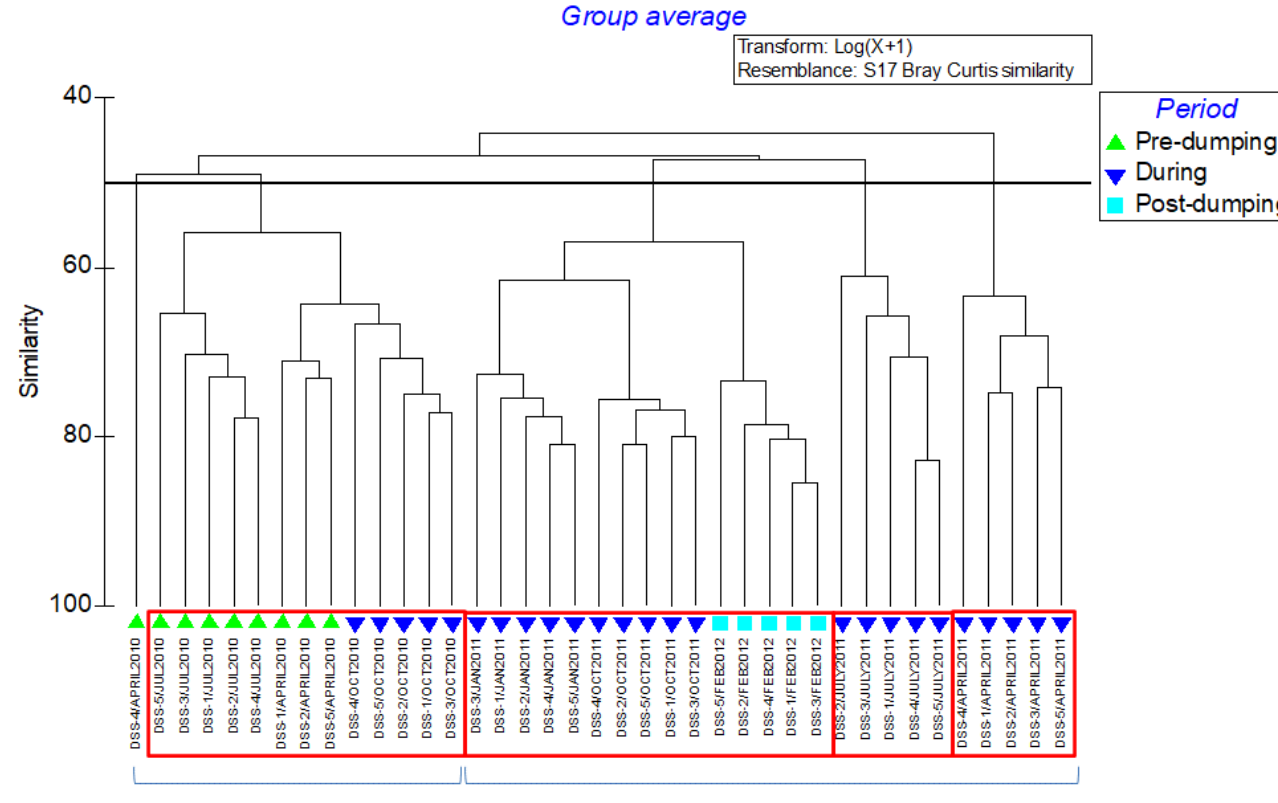
Figure 4. Cluster analysis of the phytoplankton community structure (data of species abundance, cells L − 1 ) in the sampling stations based on the different months of samplings. Data were log (x + 1) transformed. The similarity levels (% on the y’y axis) are presented among the sampling stations (on the x’x axis). The dashed line indicates the 50% similarity level above which the similarity level is considered statistically important ( p < 0.05).